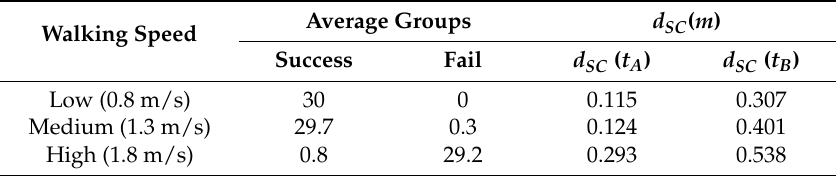
Table 1. The results of “walk-stop” experiment.